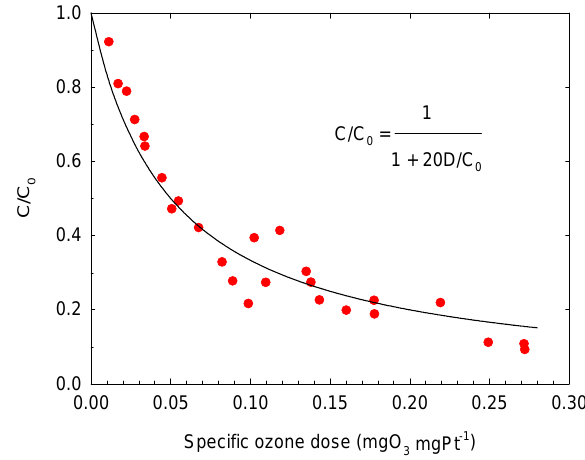
Figure 7. Color reduction versus specific ozon